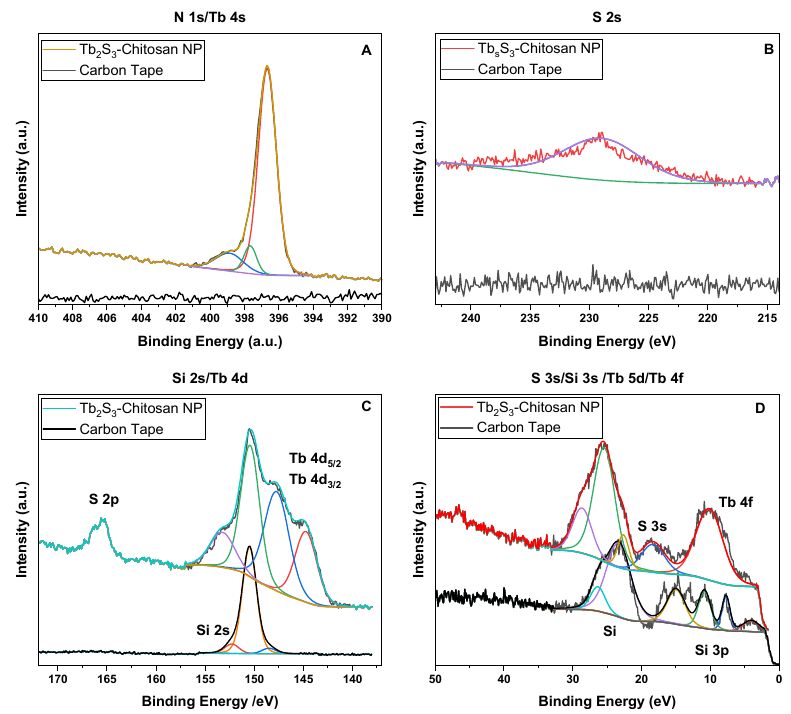
Figure 2. Narrow XPS scans across multiple regions for overlap elucidation and qualitative determination of the composition of the prepared nanoparticles: ( A ). N 1s/Tb 4s; ( B ). S 2s; ( C ). Si 2s/Tb 4d; and ( D ). S 3s/Si 3s/Tb 5d/Tb 4f. The smooth colored lines (red, blue, green, purple) are the best-fit lines for the binding energy of respective atoms to the XPS spectra.